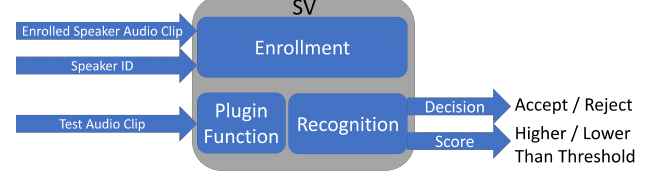
Figure 4. The proposed defense